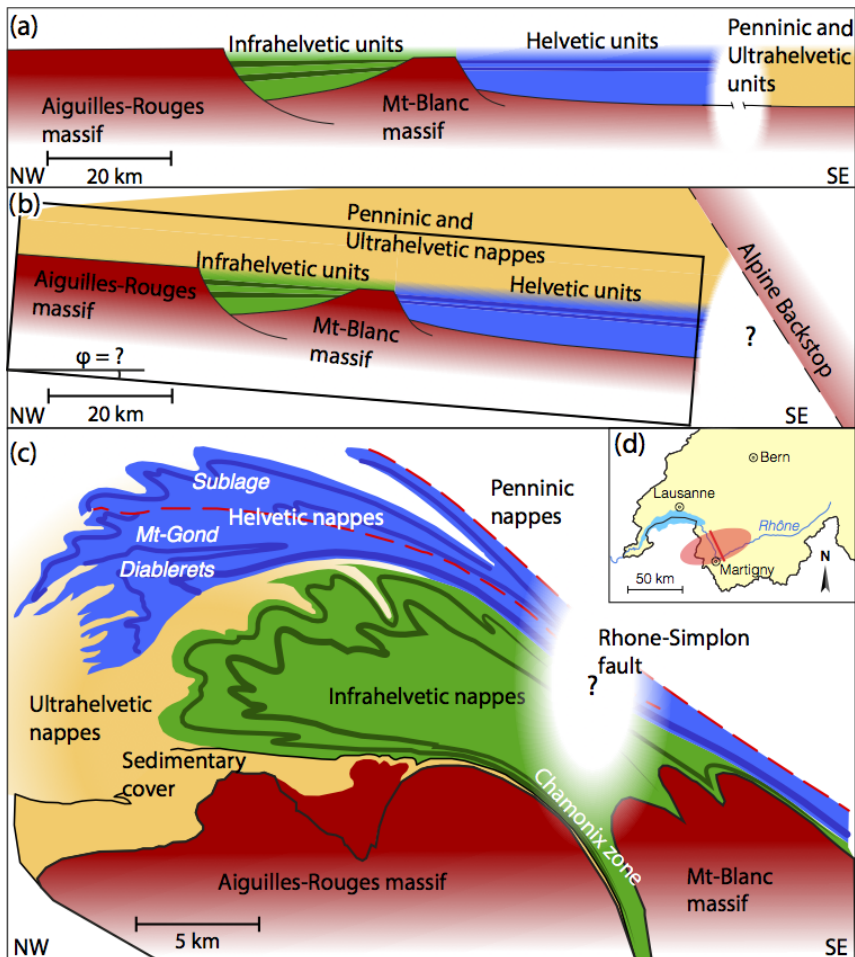
Figure 1. (a) Simplified geological reconstruction of the Mesozoic, pre-Alpine European passive margin. (b) Simplified geological recon- struction of the Alpine orogenic wedge, after emplacement of the Penninic and Ultrahelvetic units and before the Helvetic nappe stacking. The black rectangle represents the model domain of the numerical simulations. (c) Simplified geological reconstruction of the present-day structure of the Helvetic nappe system. (d) The locations of the study area (red ellipse) and the cross section (red line) are indicated on the map of